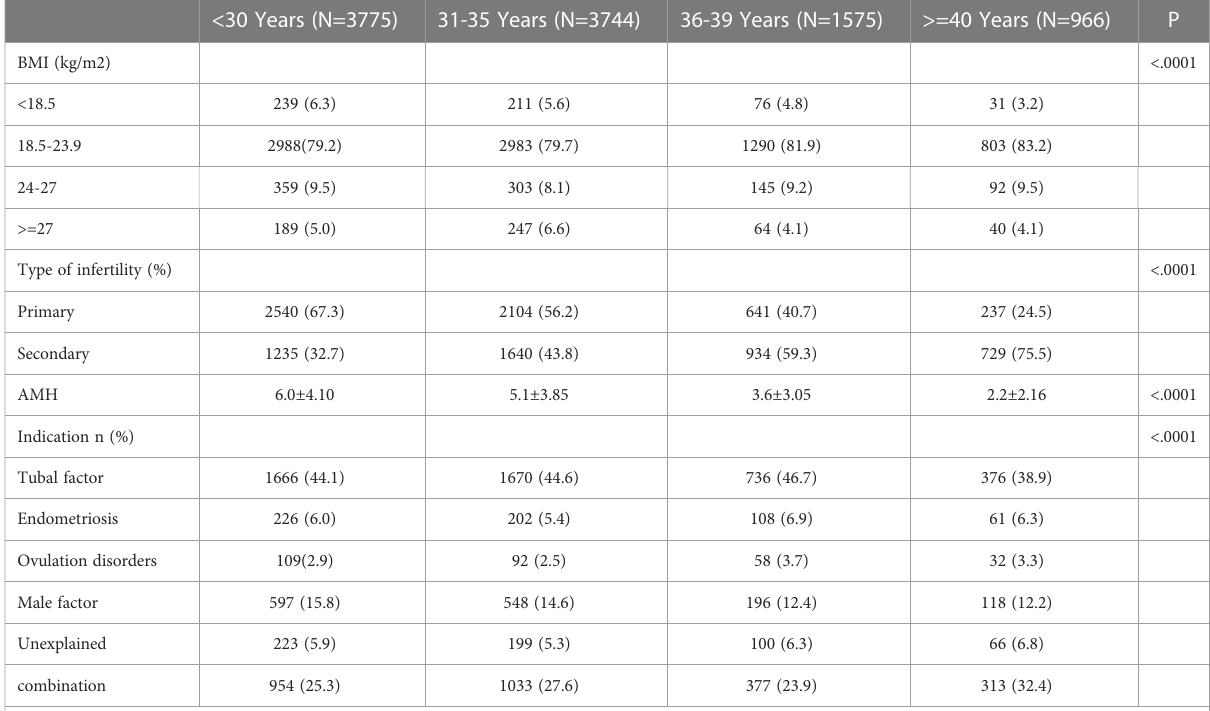
TABLE 2 Baseline characteristics of study